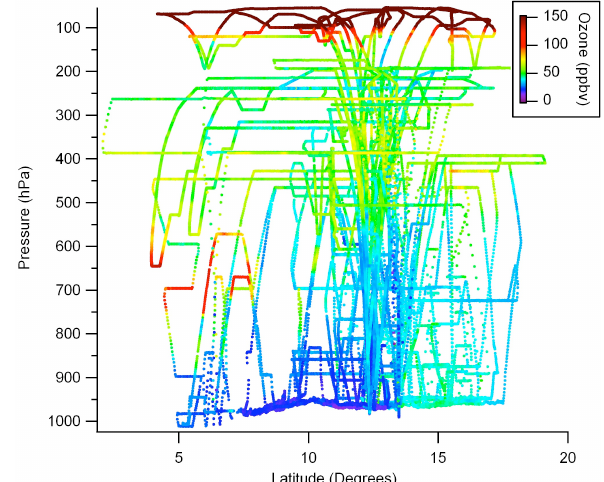
Figure 28. Flight tracks for the BAe-146, the DLR Falcon, the French Falcon and the M55 between 20 th July and 21 st August plotted as a function of latitude and altitude and coloured by the 0 3 concentration. Note that the ozone concentrations above 100 hPa are off the colour scale, extending up to 1700 ppb.